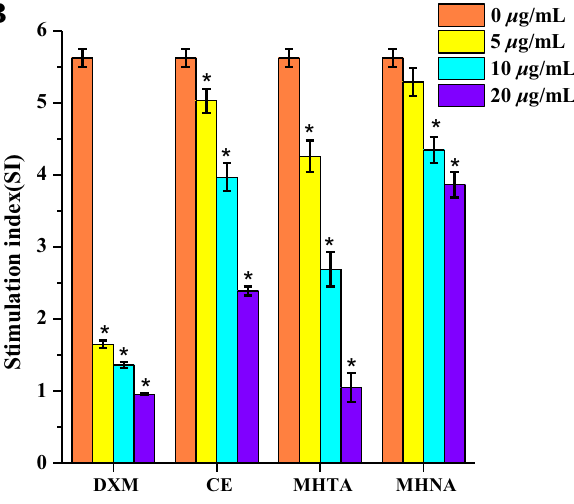
Fig. 2 Inhibitory effects of CE, MHTA and MHNA on Con A-stim- ulated T lymphocyte proliferation ( a ) and LPS-stimulated B lym- phocyte proliferation ( b ) in vitro. DXM was used as a positive con-